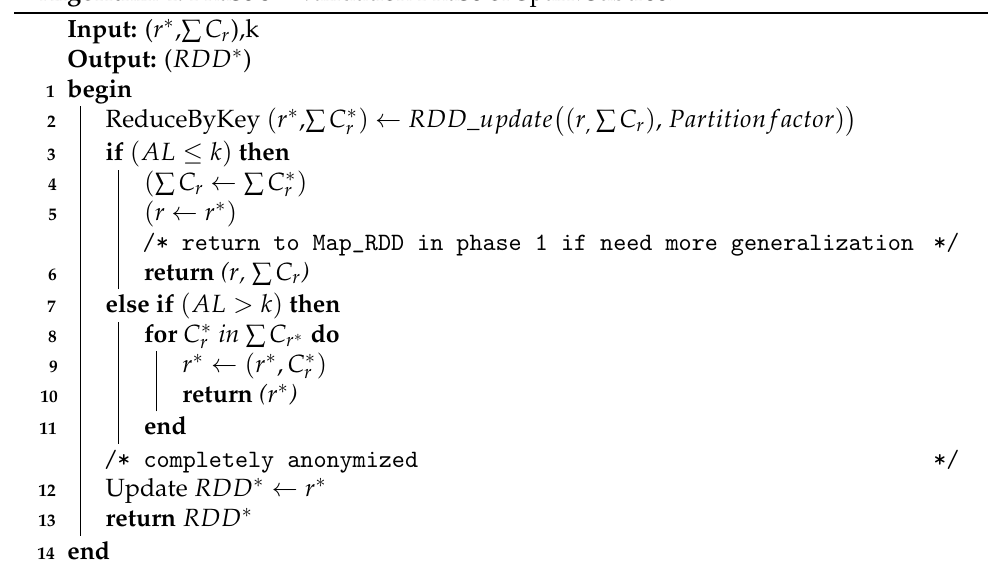
Algorithm 4: Phase 3—Validation Phase of Spark